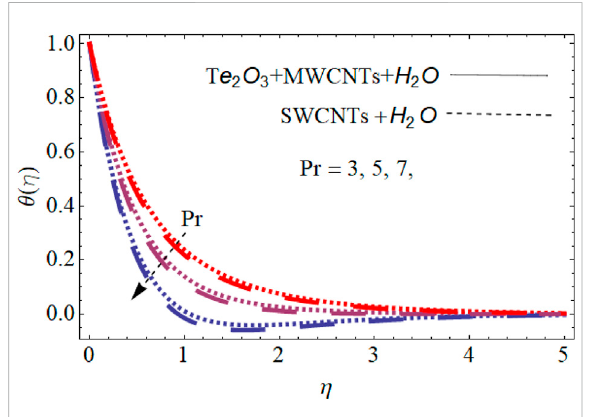
FIGURE 9 Inspiration of Prandtl number on the temperature pro fi